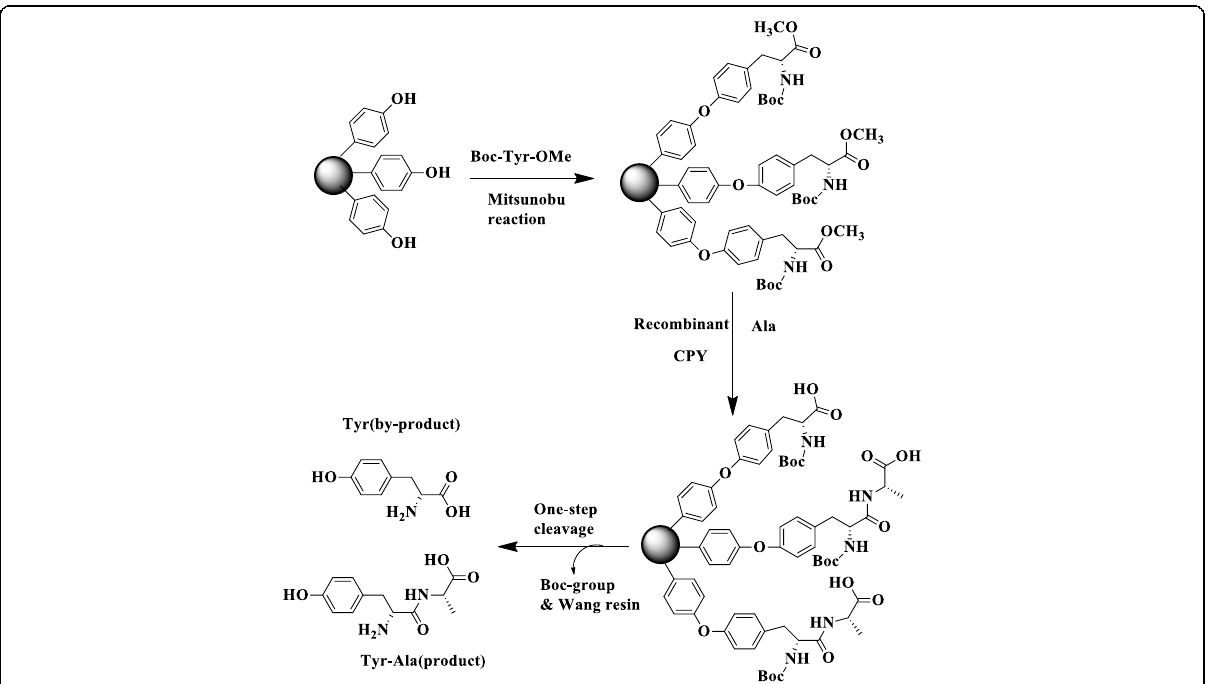
Scheme 24 Solid-phase enzymatic peptide synthesis of Tyr-Ala catalysed by CPY